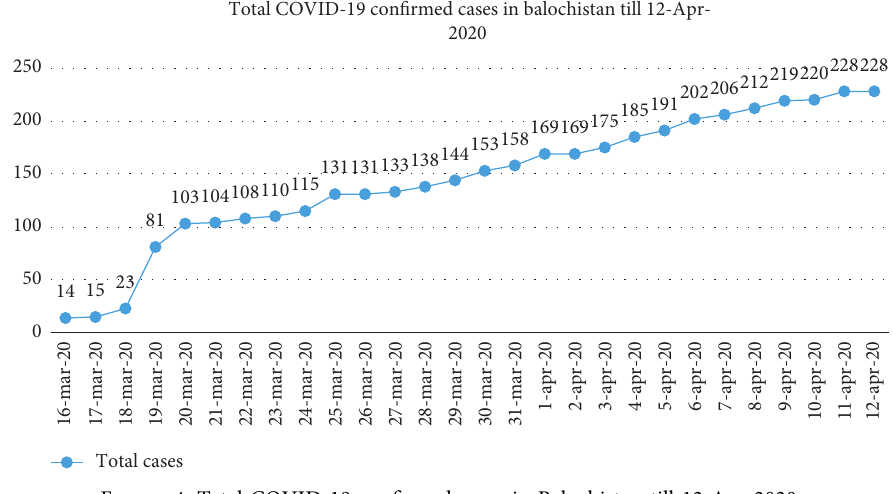
Figure 4: Total COVID-19 confirmed cases in Balochistan till 12 Apr